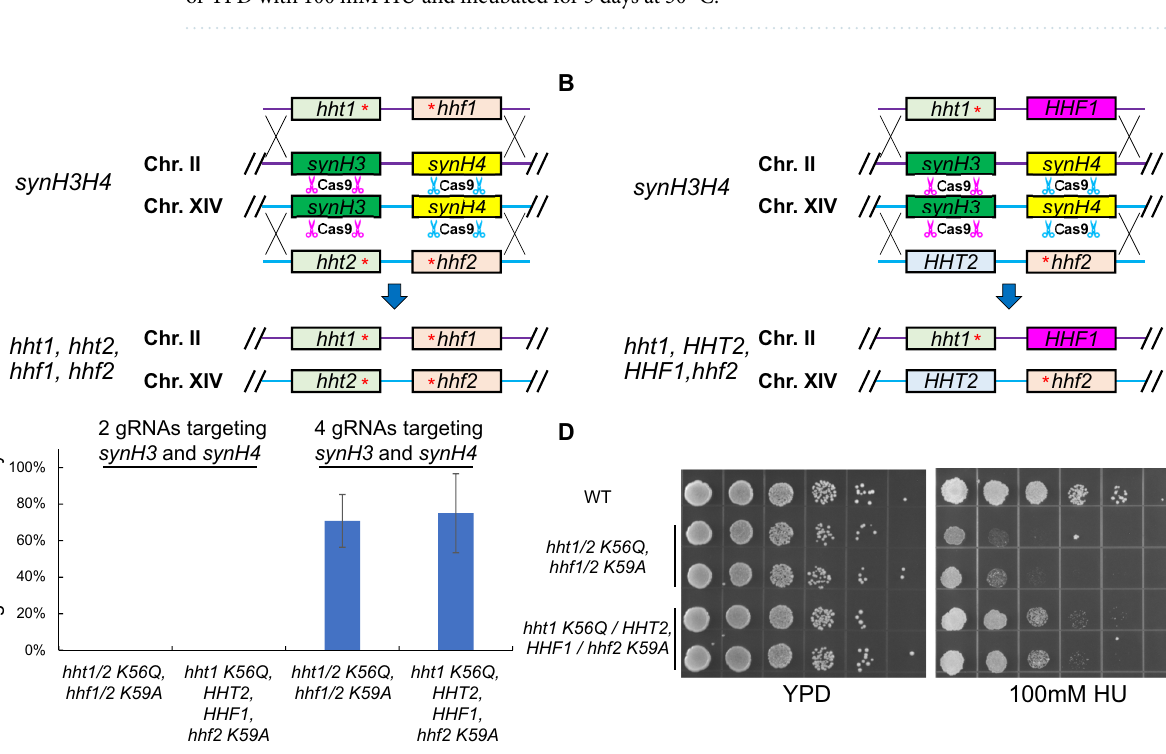
Figure 4. Confirmation of MMS and HU sensitivity of synH3H4 strain and histone H3 K4R–K36R, K79R mutant. WT stain and two biological replicates of each mutant were grown in YPD overnight at 30 °C. Serial tenfold dilutions of OD 600 = 1 yeast cultures were spotted onto YPD for 2 days, YPD with 0.05% MMS for 3 days, or YPD with 100 mM HU and incubated for 3 days at 30 °C.